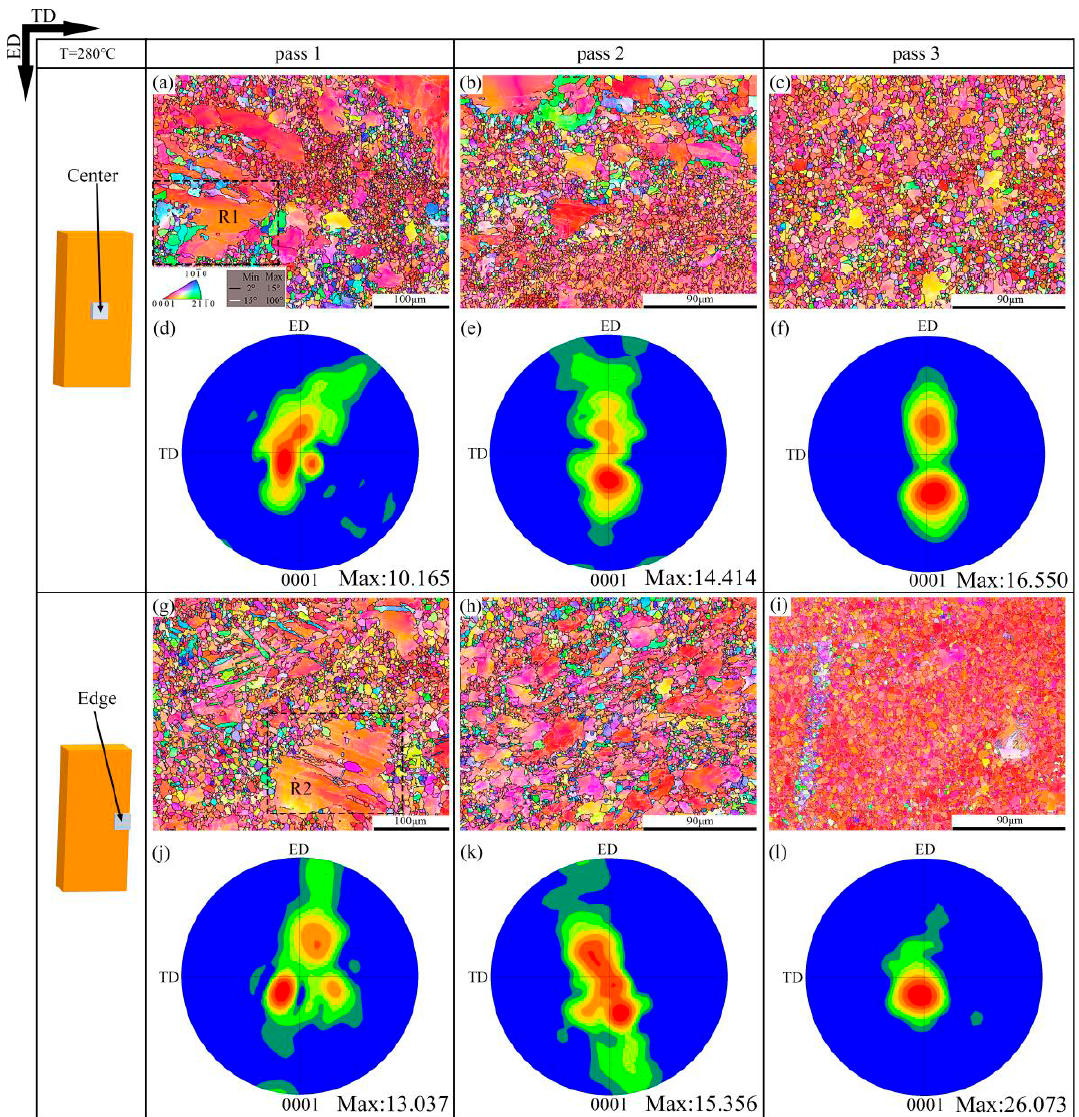
Figure 5. The electron back-scattered diffraction (EBSD) inverse pole figure (ipf) maps and (0001) pole figure maps of the CEE-AEC samples at 280 °C: ( a ) IPF map of Center pass 1; ( b ) IPF map of Center pass 3; ( c ) IPF map of Center pass 3; ( d ) The corresponding (0001) pole figure in (a); ( e ) The Edge pass 1; ( h ) IPF map of Edge pass 2; ( i ) IPF map of Edge pass 3; ( j ) The corresponding (0001) pole